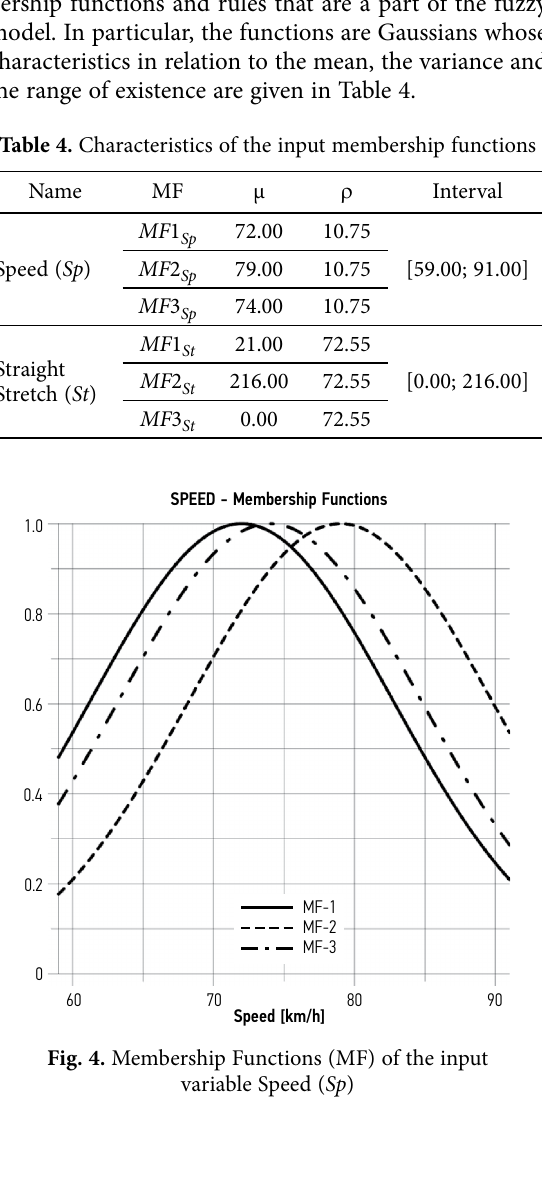
Fig. 3. Determination of the best number of epochs by means of training (green) and checking (red) curves